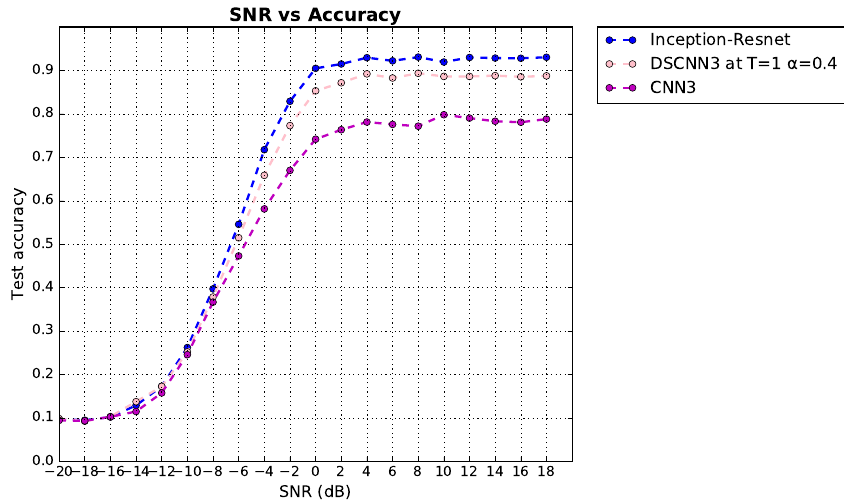
Figure 15. Classification accuracy of teacher network, student network and the best network after knowledge distillation. (DSCNN3 represents CNN3 after knowledge distillation).